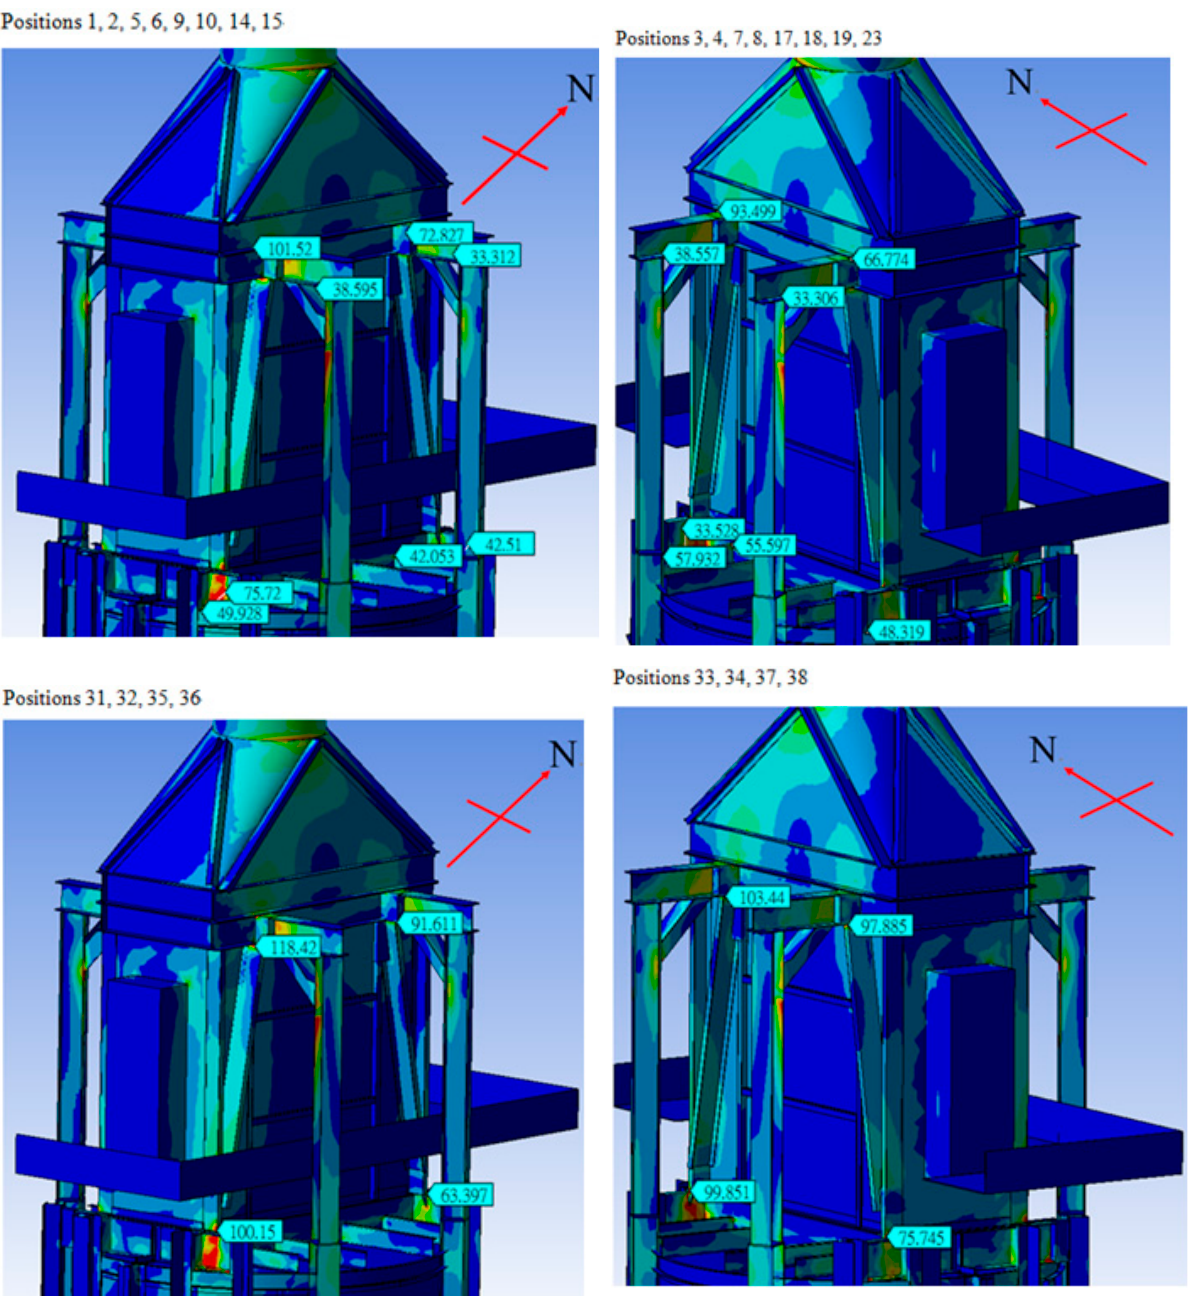
Figure 7. Results of finite element analysis for the present heater.